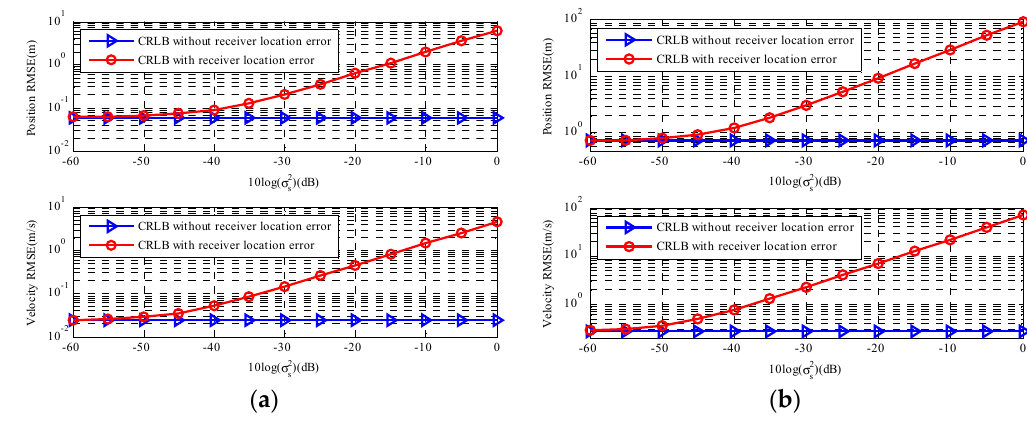
Figure 3. CRLB comparison versus sensor location error. ( a ) The near-field moving source; ( b ) The